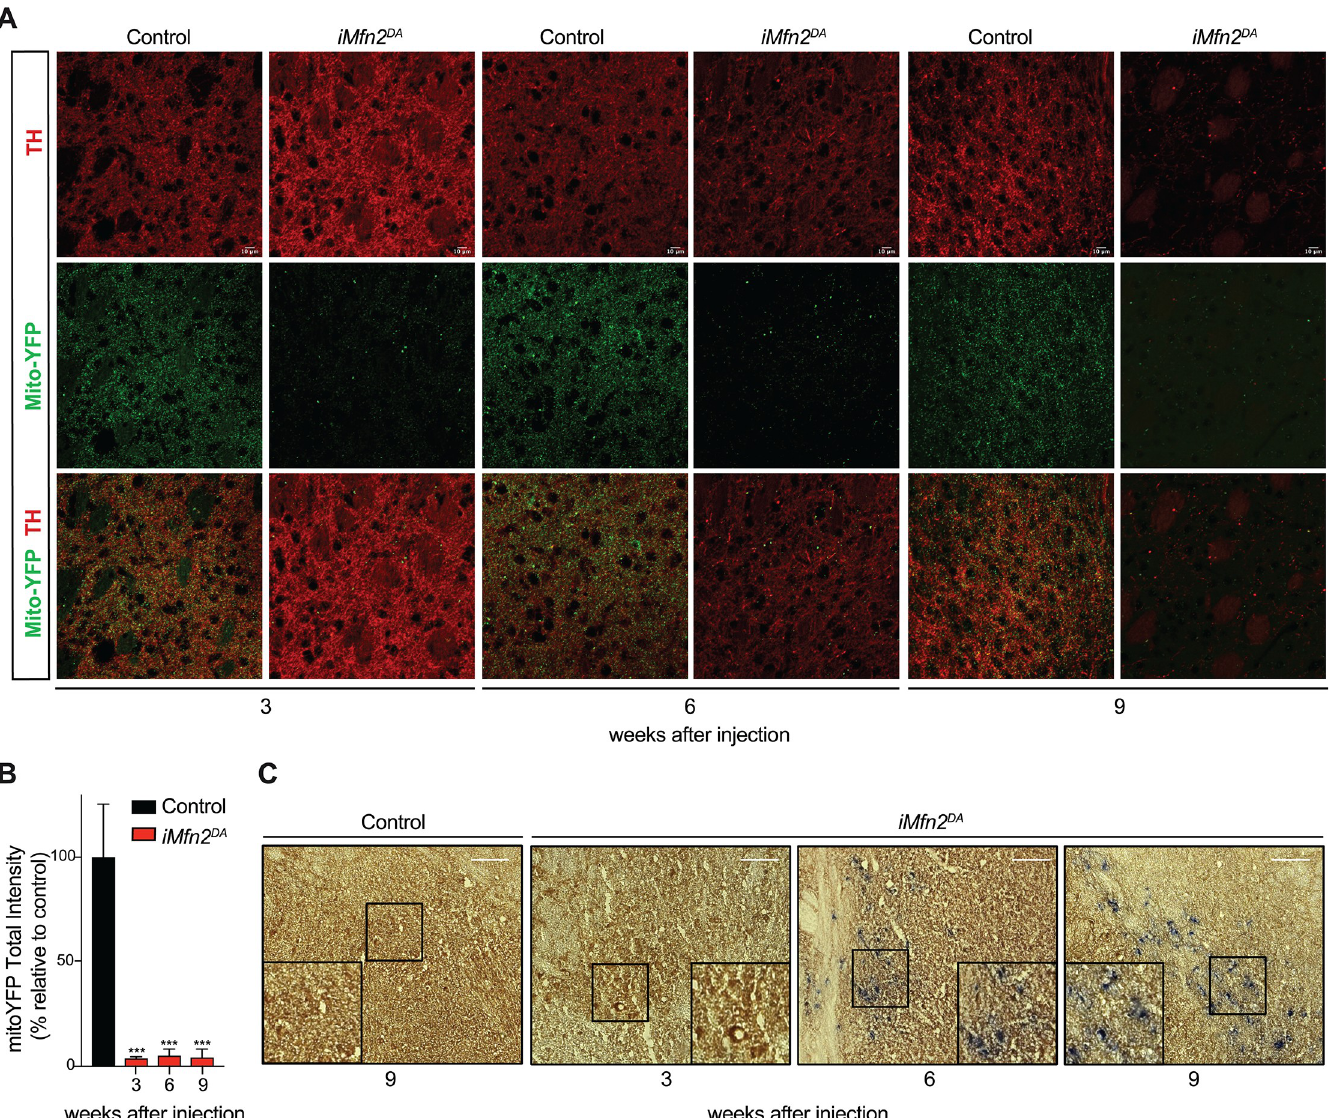
Fig 3. Tamoxifen-injected iMfn2 DA mice exhibit impaired axonal mitochondrial transport and OXPHOS deficiency. (A) MitoYFP-labelled mitochondria in TH + nerve terminals of the striatum at 3, 6 and 9 weeks after tamoxifen injection (Scale bars: 10 μ m). (B) Quantificantion of mitoYFP-labelled mitochondria total intensity in the striatum of control and tamoxifen-injected iMfn2 DA mice at 3, 6 and 9 weeks after tamoxifen injection. Data are shown as mean ± SD. � p < 0.05, ��� p < 0.001, n = 3 for genotype. (C) Cytochrome c oxidase and succinate dehydrogenase (COX/SDH) double-labelling enzyme histochemistry of the midbrain (Scale bars: 100 μ m).